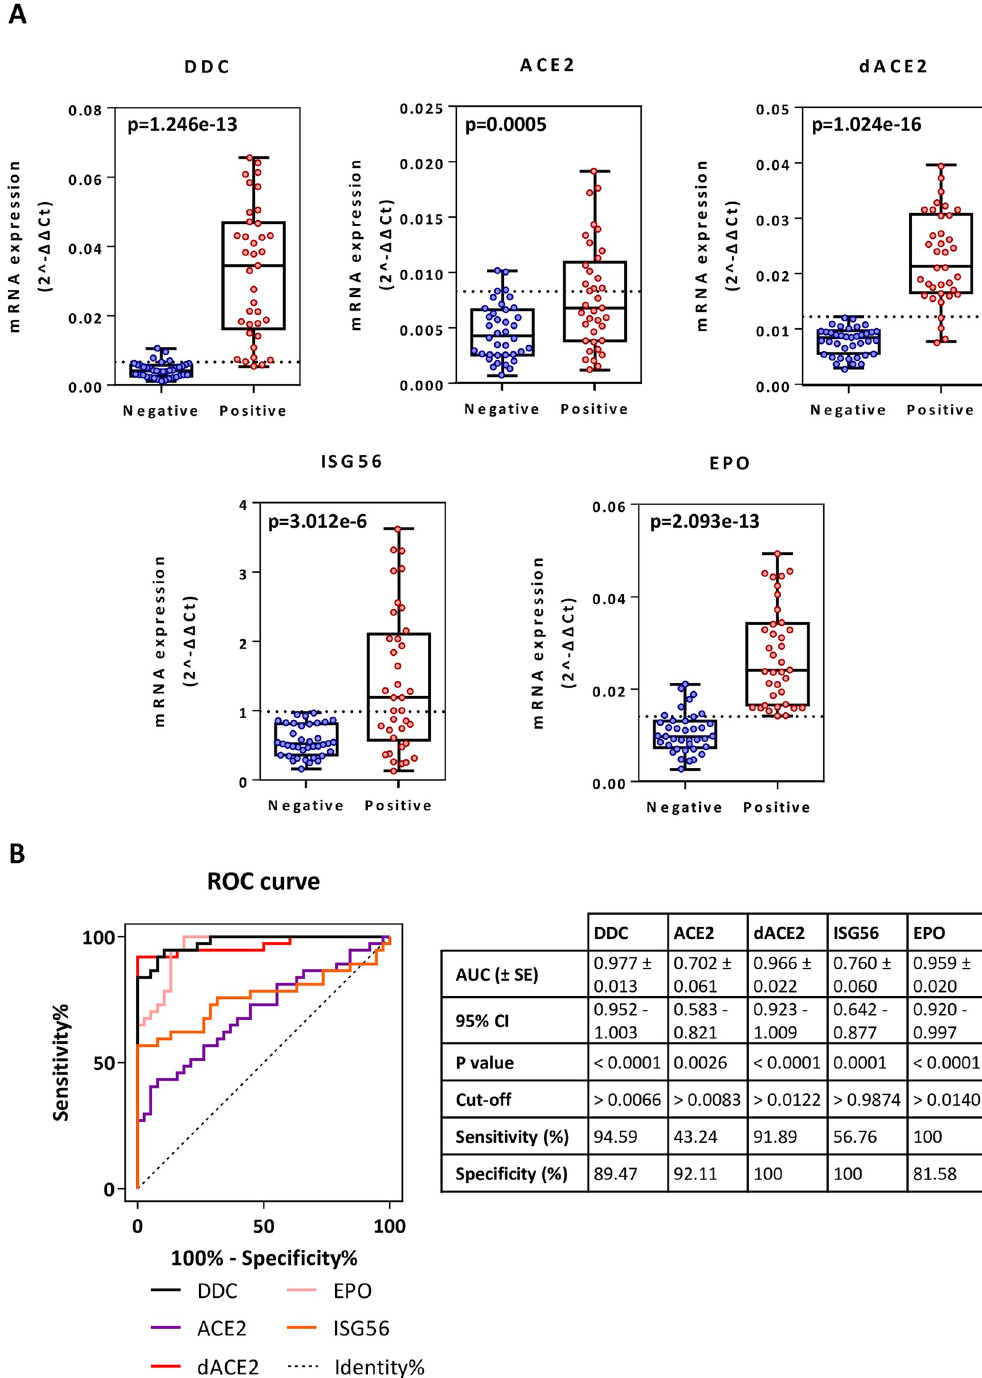
Fig 1. Comparison of DDC , ACE2 , dACE2 , ISG56 and EPO mRNA expression in nasopharyngeal swab samples between COVID-19 patients showing no or mild symptoms and non-infected individuals (A) and ROC curve analysis (B). Relative mRNA values (mean 2 - ΔΔ Ct ) from the patient (n = 37) and control (n = 38) groups. The horizontal dotted line indicates the optimal threshold value (cut-off). Data are represented as box plots; line in the middle, median; box edges, 25 th to 75 th centiles; whiskers, range of values. p values were calculated with the student’s t-test. ROC curves were generated and AUC, 95% CI, p values and cut-off points with their specificity and sensitivity were calculated.